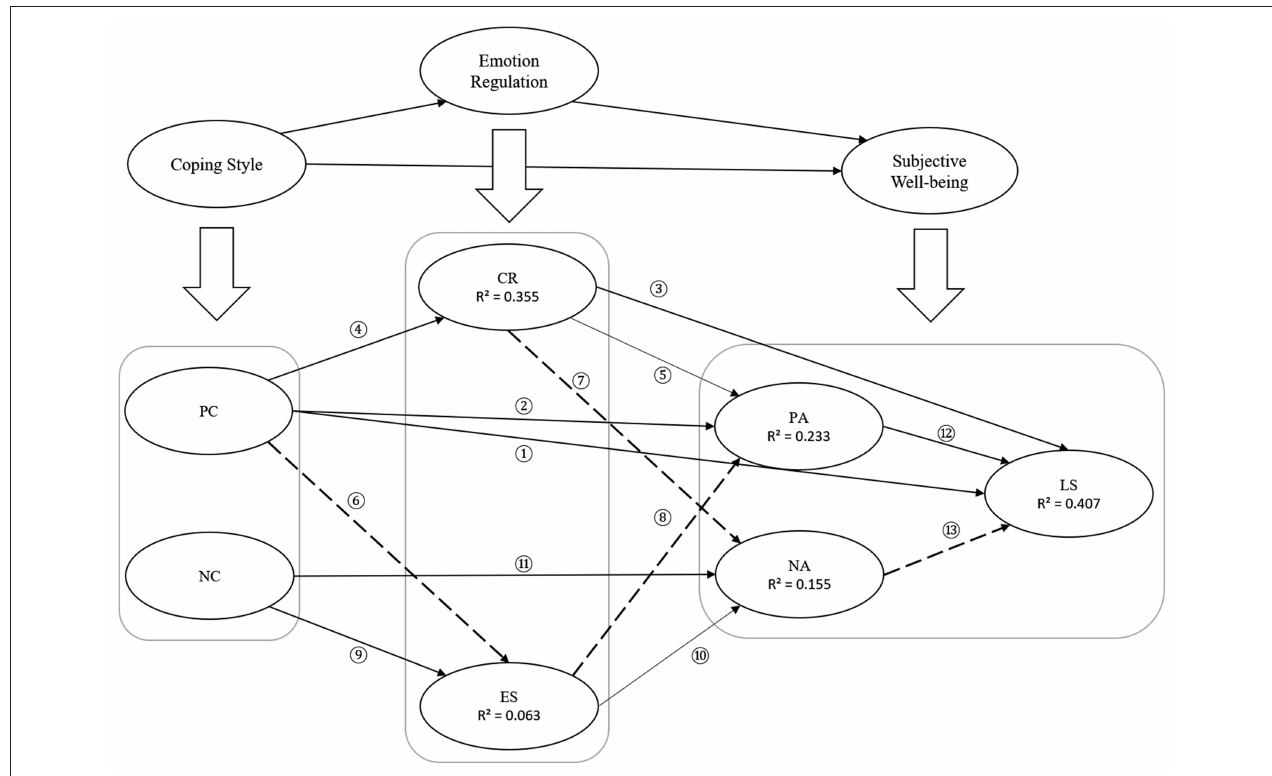
FIGURE 5 | The final structural model for the relationships among coping styles, emotion regulation, and SWB; all the lines shown in the figure were significant ( p < 0.05); the full lines meant the positive effect, and the imaginary lines meant the negative effect; the path number corresponded to Table 4 . PC, positive coping; NC, negative coping; CR, cognitive reappraisal; ES, expression suppression; PA, positive affect; NA, negative affect; LS, life satisfaction; SHAP, SHapley Additive exPlanation.